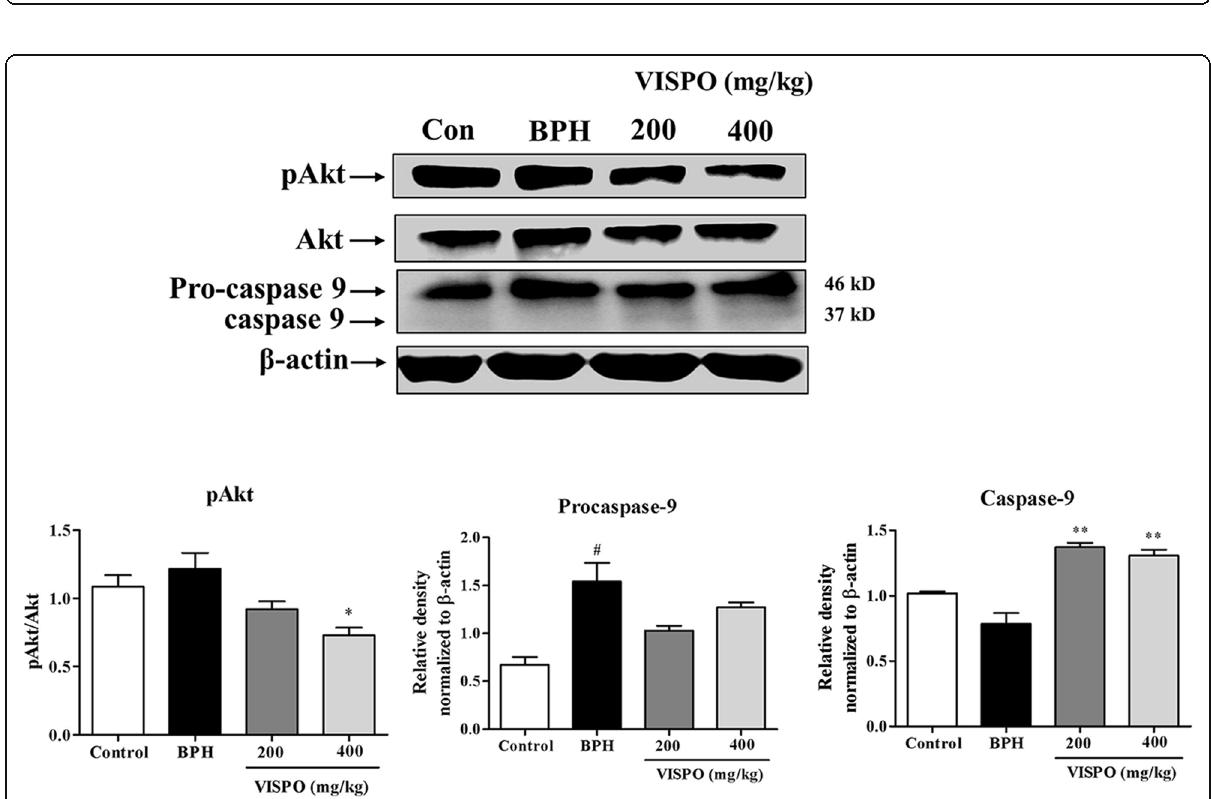
Fig. 6 Effect of VISPO administration on the expression of pAkt and caspase-9 in prostate tissue of BPH model rats. The protein expression was determined by western blotting using specific antibodies. β -actin was used as loading control. Densitometric analysis was performed using ImageJ software. The data presented as mean ± SEM (# p < 0.05 and ### p < 0.001 vs. control group; ** p < 0.01 and *** p < 0.001 vs. BPH